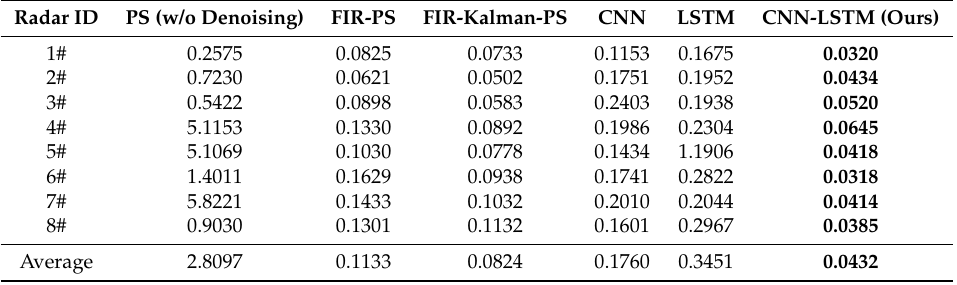
Table 3. Comparison of the proposed method with different methods on the testing set (mean absolute error, MAE). PS: peak